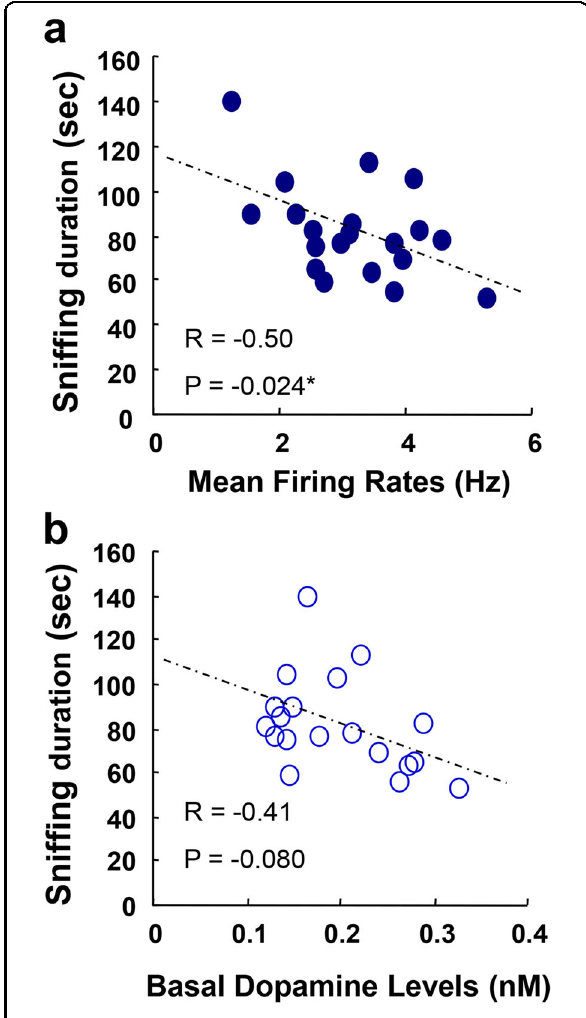
Fig. 5 A negative correlation between dopaminergic cell fi ring in the ventral tegmental area and social interaction score. a To evaluate the regulatory strength of the dopaminergic activity on social behaviors in the above DREADD experiment, individual fi ring rates of the putative VTA dopaminergic neurons in Fig. 4 were averaged for each rat, plotted against their social interaction scores (i.e., their snif fi ng duration) and subjected to the Pearson ’ s correlation analysis. b Similarly, resting-state dopamine concentrations in the prelimbic cortex were subjected to the correlation analysis with social interaction scores. A rat losing the cannulation probe was excluded from the fi nal analysis. Animal allocation and data sharing between Figs. 4 and 5 are presented in Supplemental Table